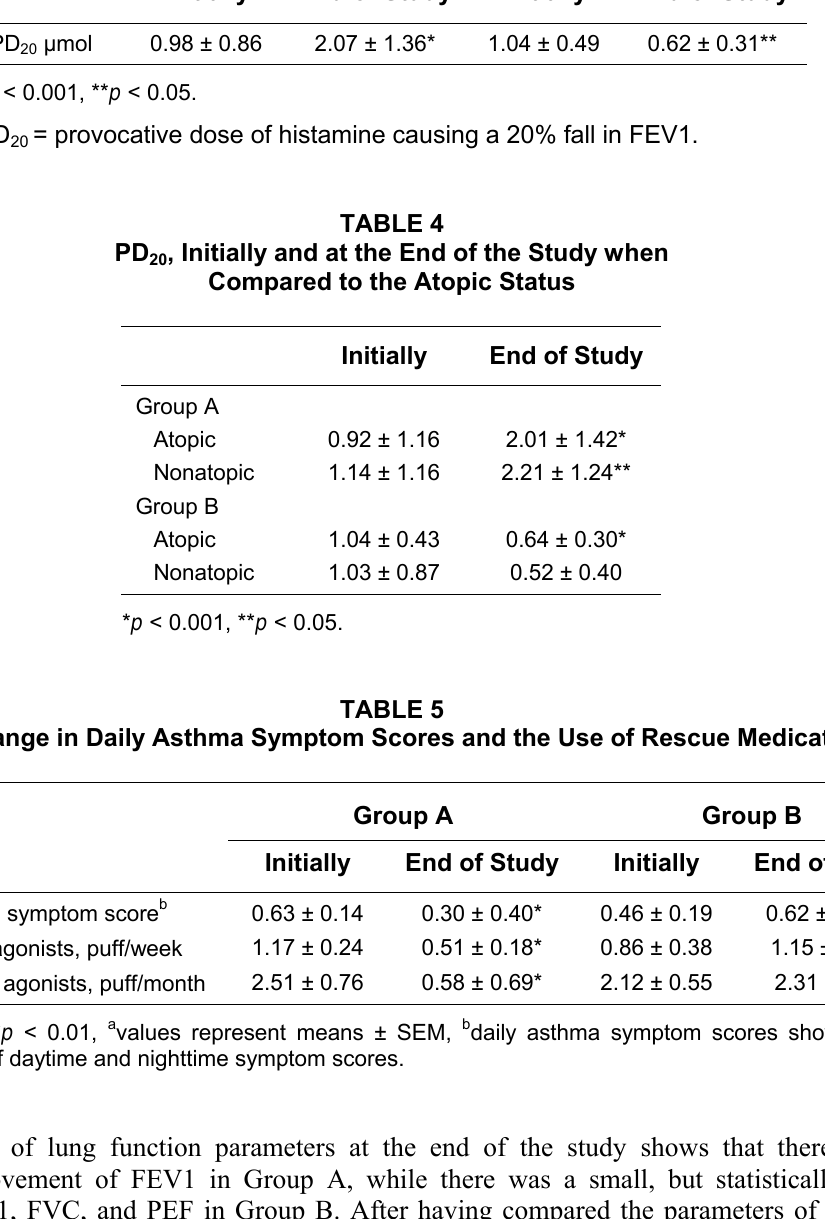
PD20, Initially and at the End of the Study Group A Group B